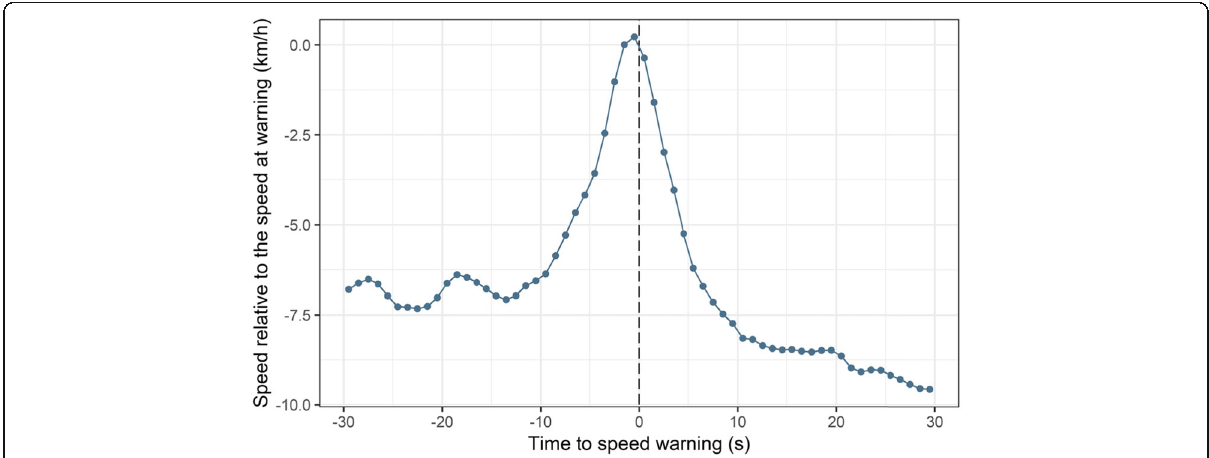
Fig. 8 Speed profile at warnings: the average speed 30 s before and after the warning relative to the speed at the